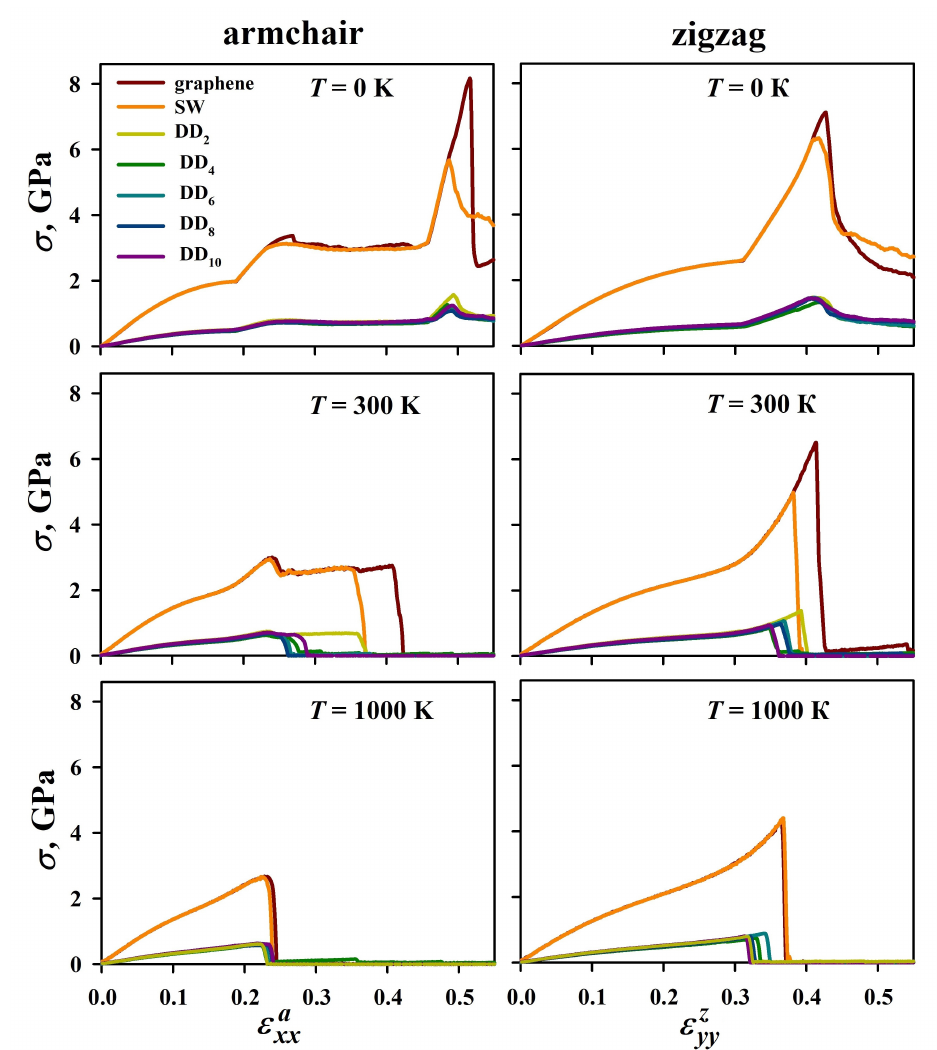
Figure 2. Stress-strain curves for graphene, graphene with SW defect and with DD n under tension along armchair/zigzag direction at three